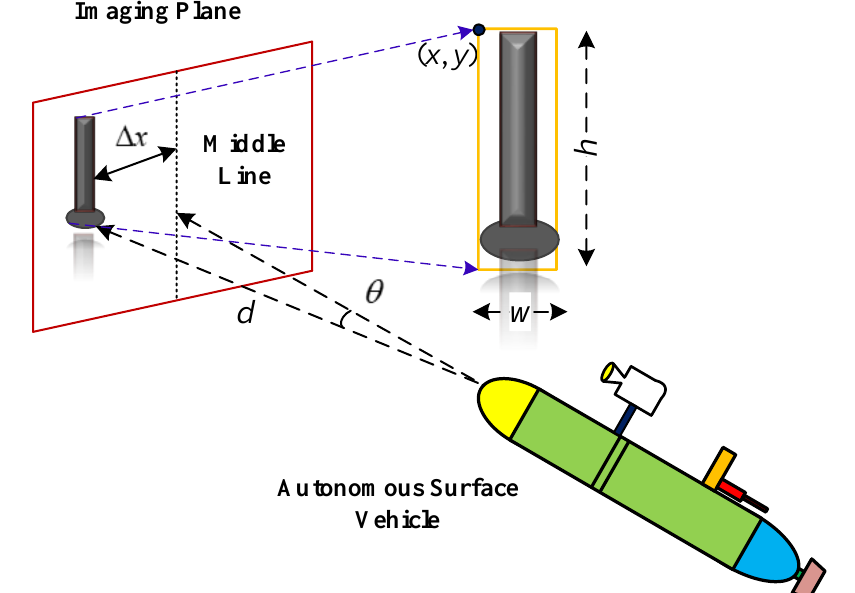
Figure 9. Long-strip target tracking principle.